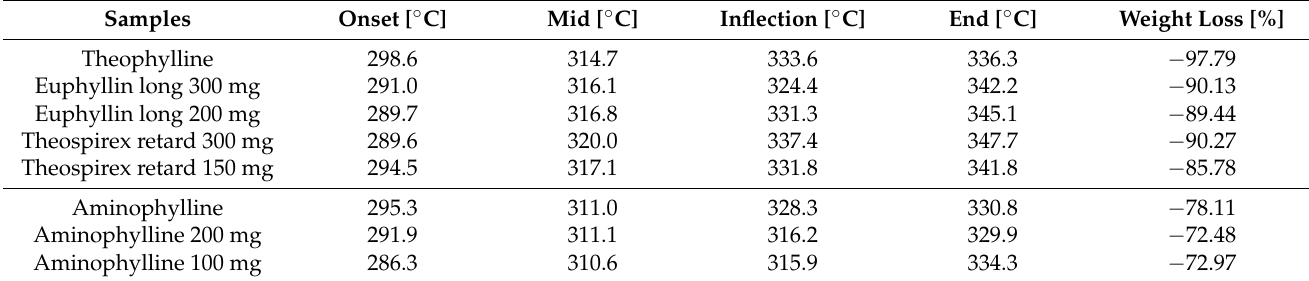
Table 1. The characteristic parameters of TGA curves of the tested